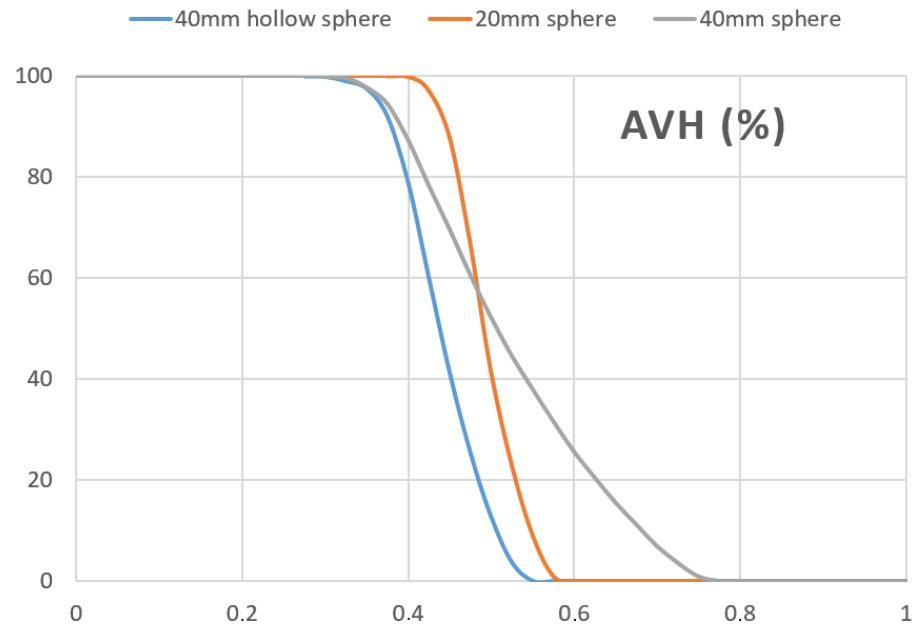
Figure 11. AVHs of ROIs delineated on Abdo-Man phantom corrected using the RC j reported in Figure 9.